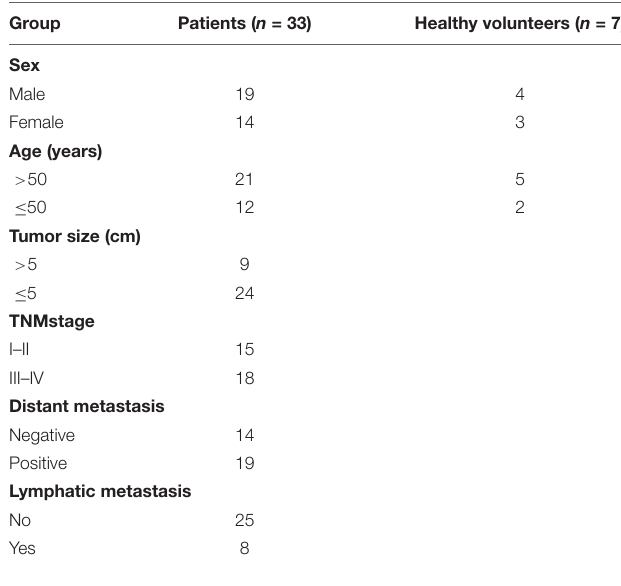
TABLE 1 | Characteristics of patients with gastric cancer and healthy